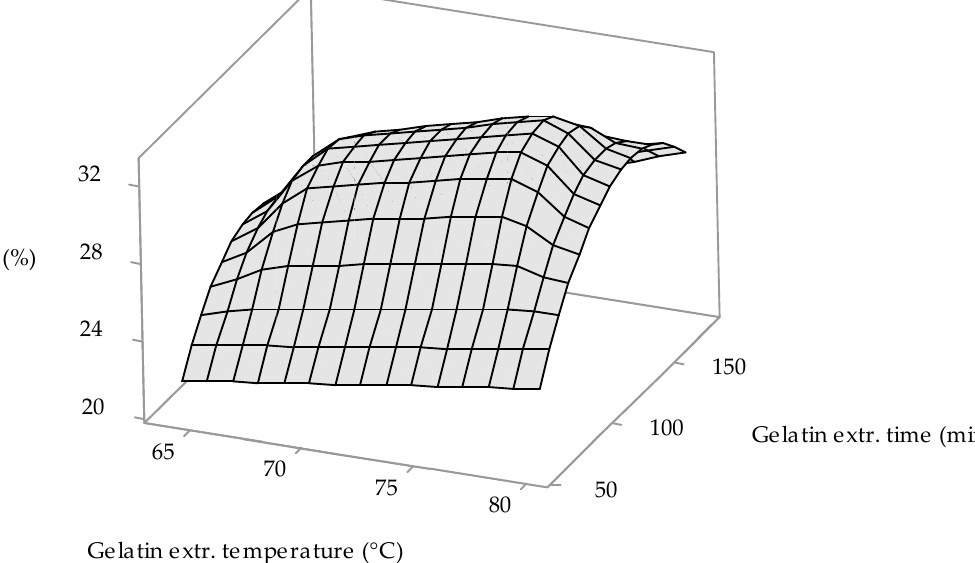
Figure 1. The influence of the gelatin extraction temperature and gelatin extraction time on the 1st gelatin fraction yield.